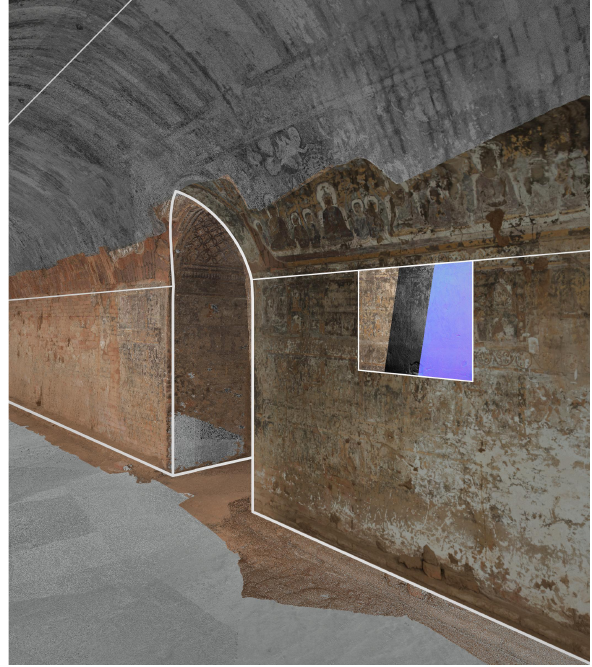
Figure 7. Layered datasets of Myin-pya-gu temple.